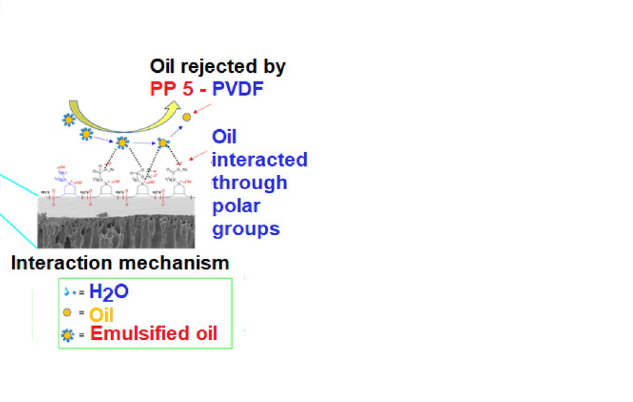
Figure 11. Mechanism of separation of oil-in-water